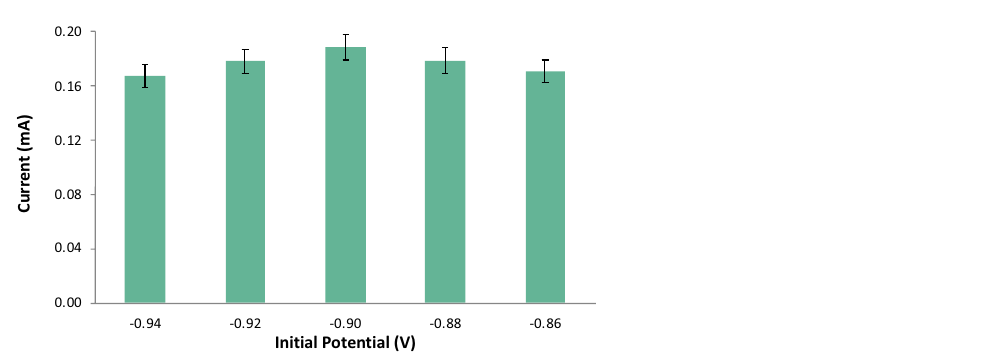
Figure 9. Anodic current peaks for varying initial